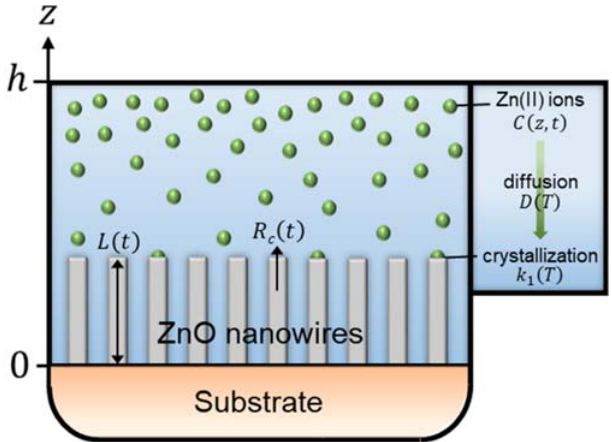
Figure 1. Schematic of the geometry used to establish the theoretical model describing the time- dependent axial growth rate and length of ZnO NWs by CBD under dynamic conditions, where a finite reactor height, h , is considered.